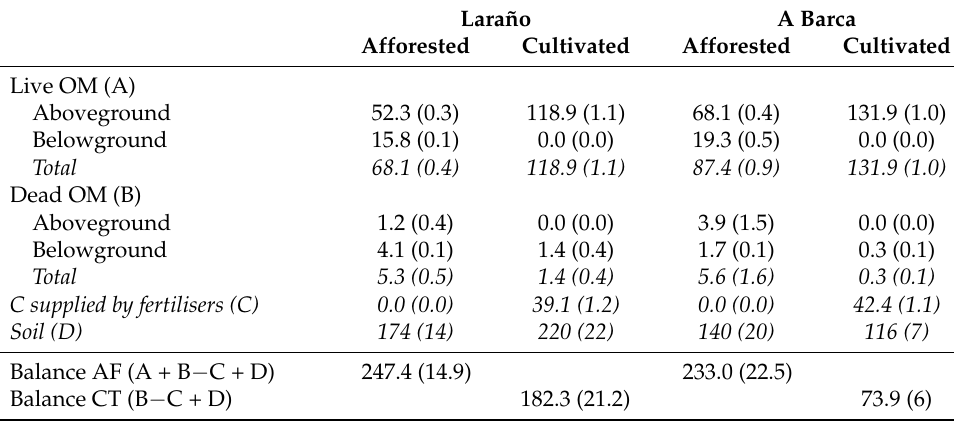
Table 7. Ecosystem C stocks and C balances (Mg C ha − 1 ; mean and standard deviation, in brackets): live organic matter C stock + dead organic matter C stock + soil C stock—C supplied by fertilisers in afforested plots (AF) and dead organic matter C stock + soil C stock—C supplied by fertilisers in cultivated plots (CT). Laraño A Barca Afforested Cultivated Afforested